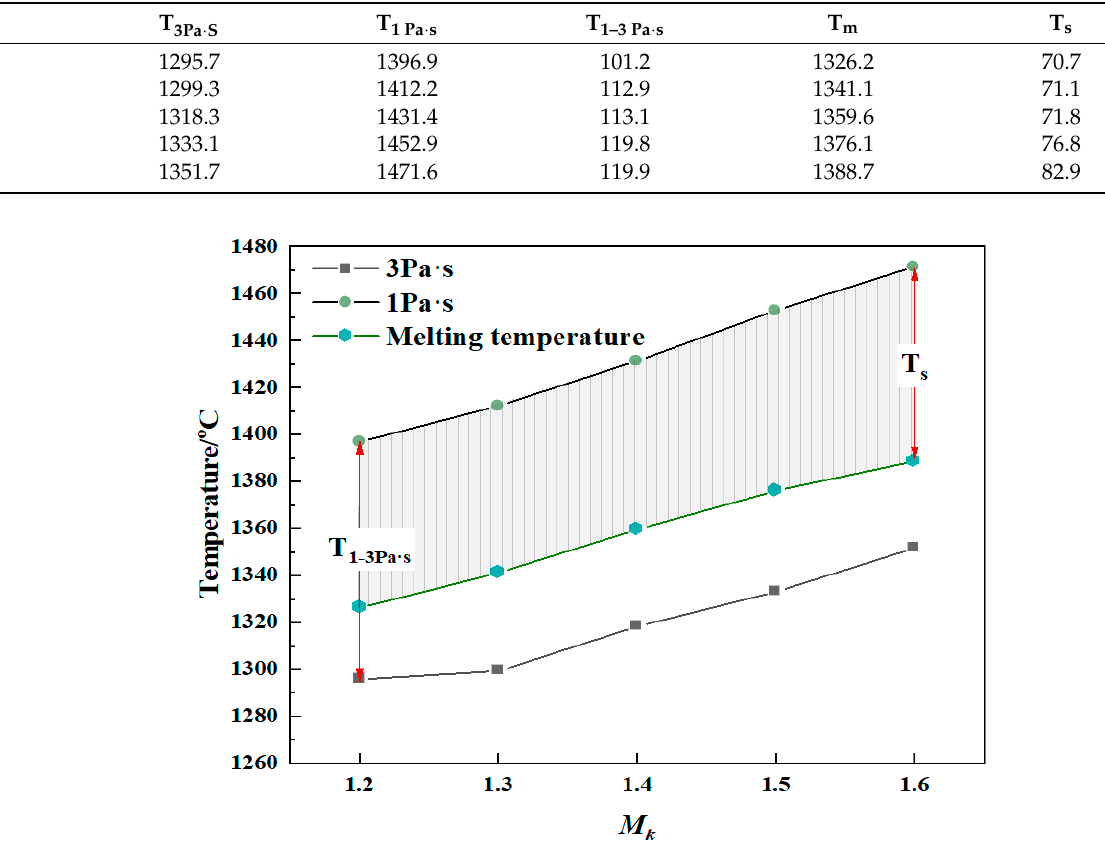
Figure 5. Effect of the M k value on the melting temperature of modified blast furnace slag.